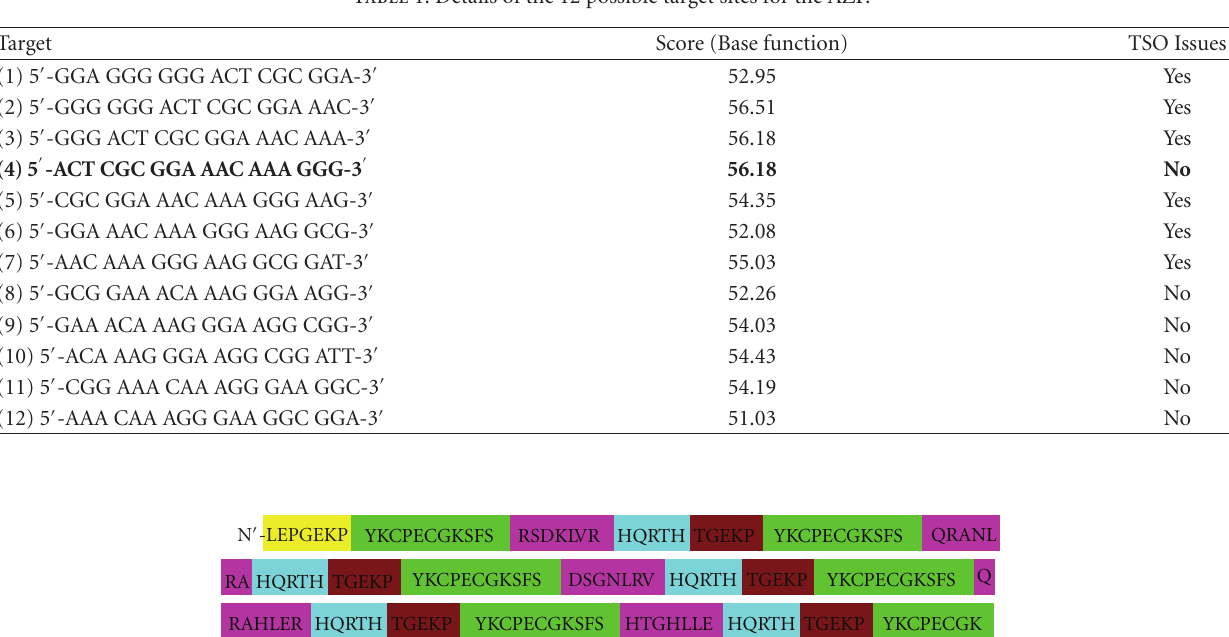
Table 1: Details of the 12 possible target sites for the AZP.